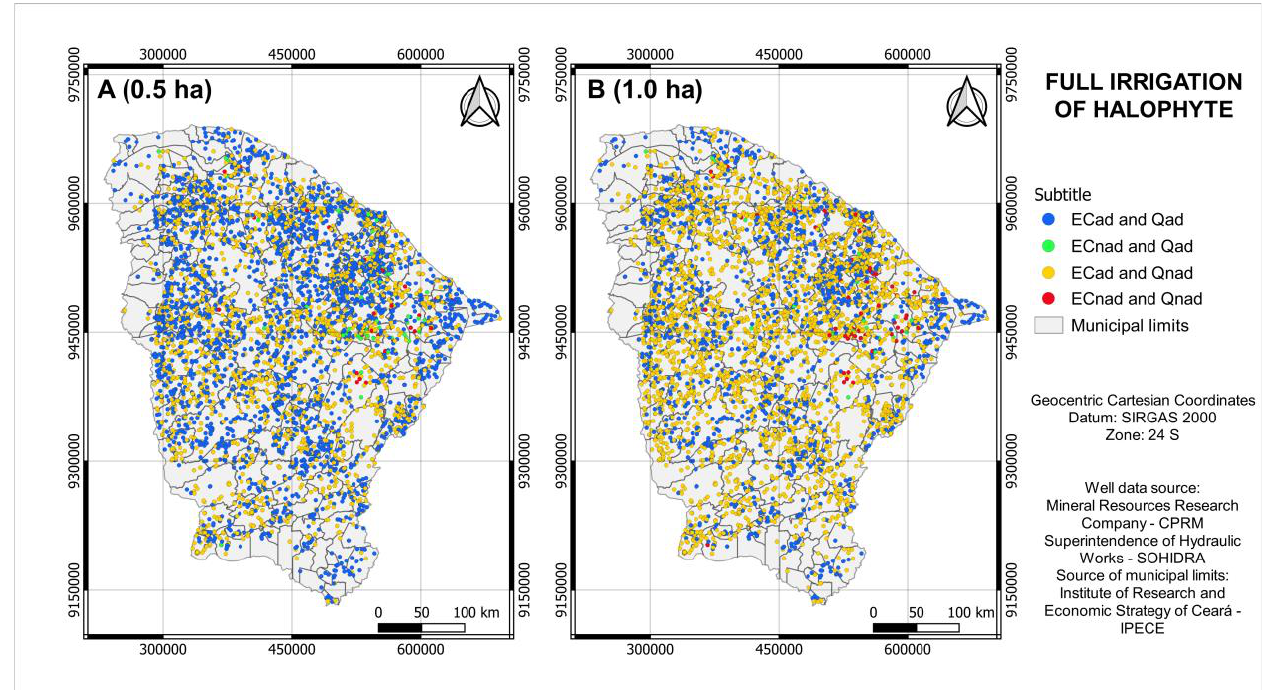
Figure 2. Potential of brackish groundwater in the State of Ceará (Northeast Brazil) for full irrigation of halophytes in 0.5 ha ( A ) and 1.0 ha ( B ), based on the threshold electrical conductivity of the irrigation water (EC) and discharge rate (Q). EC ad : adequate electrical conductivity; EC nad : inadequate electrical conductivity; Q ad : adequate discharge; Q nad : inadequate discharge.